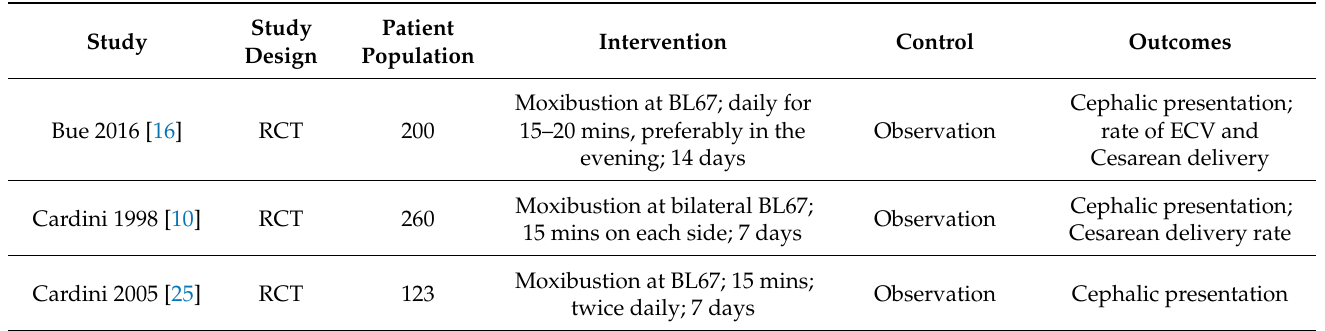
Figure 1. Flow chart of the identification and selection of studies for inclusion. Table 1. Characteristics of the included studies.